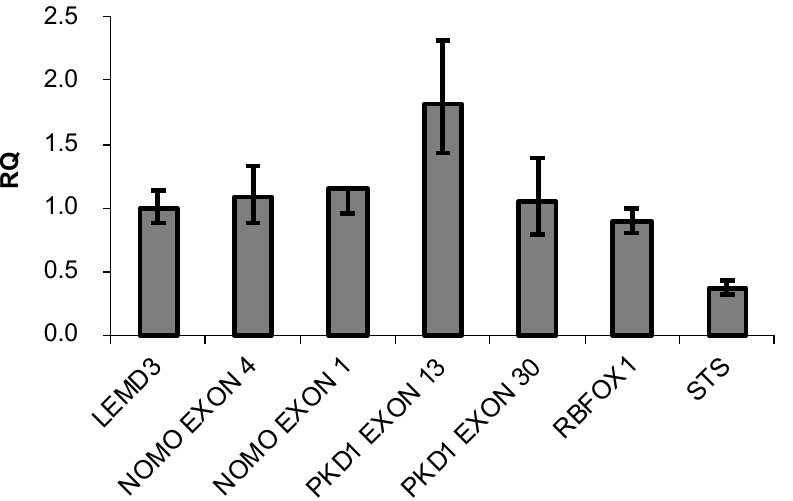
Figure 1. DNA content of the indicated genes determined by q-PCR. Data are presented as the mean of three replicates ± SD. RQ represents the relative expression levels of each amplicon normalized with a control ( LEMD3 ).